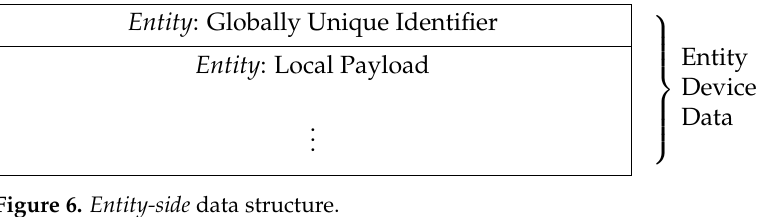
Figure 6. Entity-side data structure.